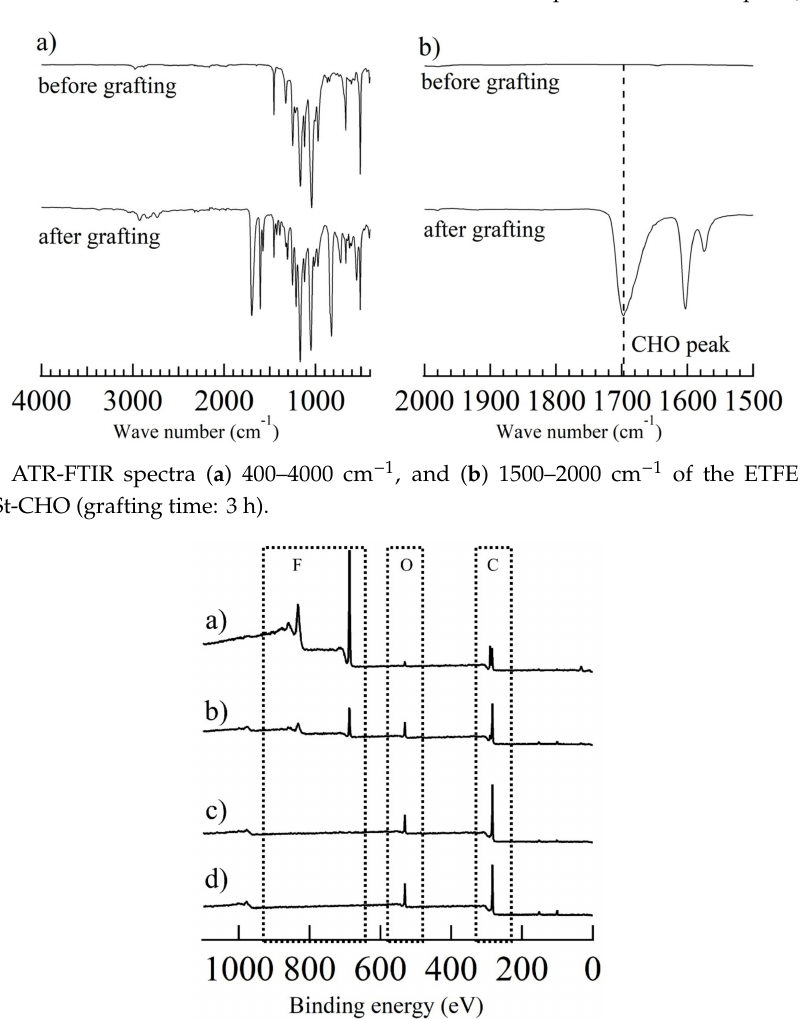
Figure 1. E ff ect of polymerization time on the grafting degree (GD), for the graft polymerization of St-CHO on the pre-irradiated poly(ethylene- co -tetrafluoroethylene) (ETFE) film (lines are inserted for guidance, and bars indicate standard errors calculated for three experiments for each point).